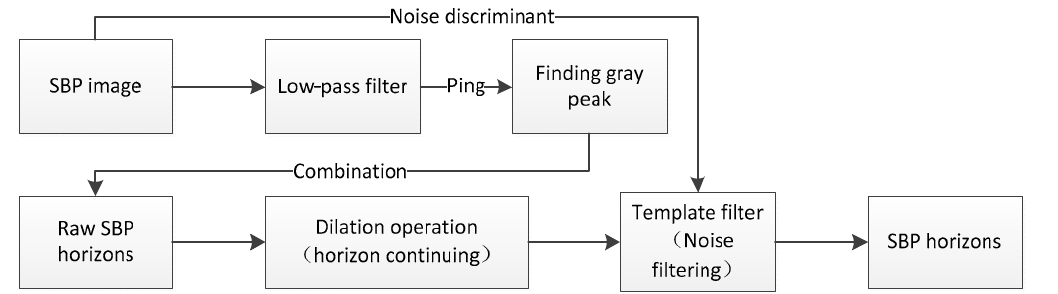
Figure 12. The process of automatic horizon picking.